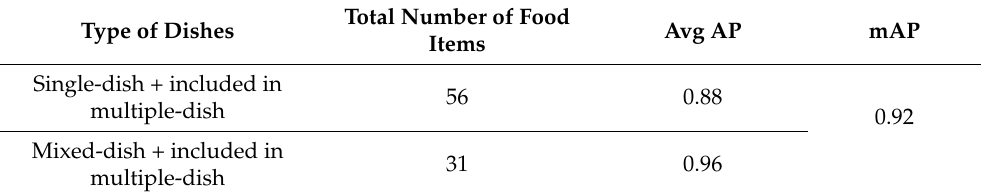
Table 6. AP value of all types of